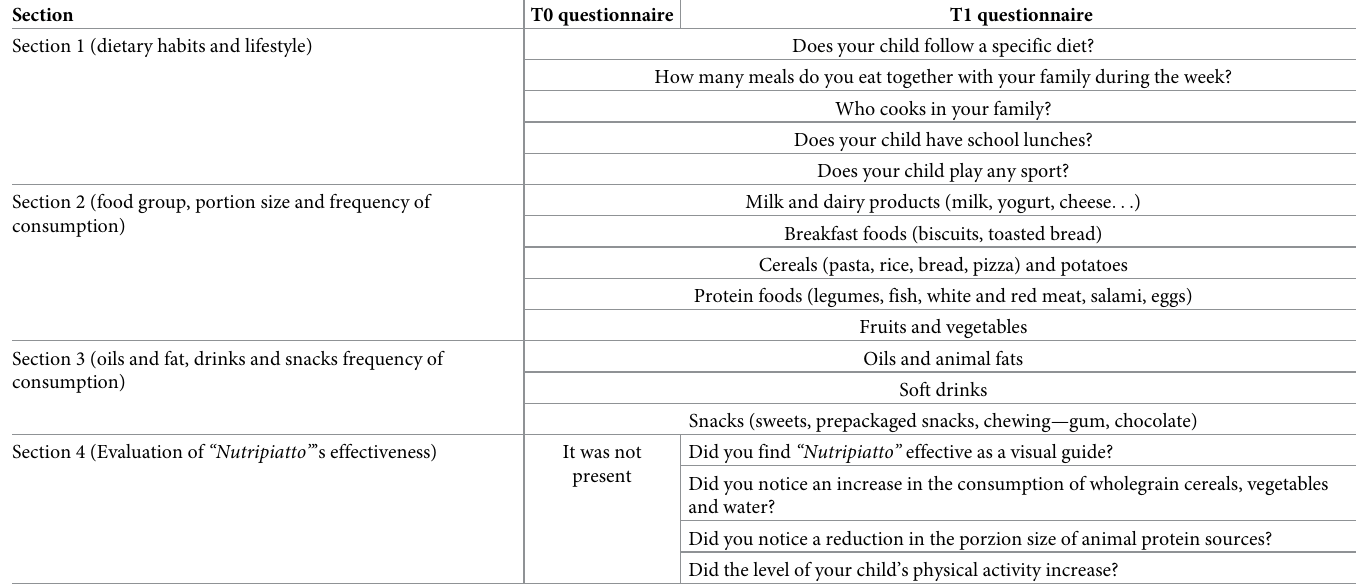
Table 3. Structure of the FFQs. FFQ used at T0 and T1 to evaluate children’s dietary habits and physical